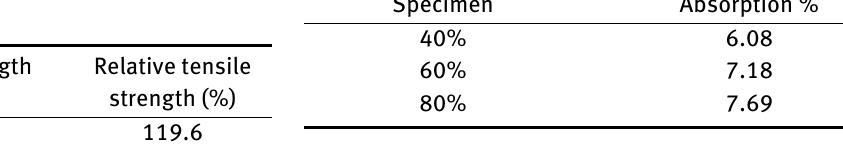
Table 21: Flexural strength of geopolymer mortar reinforced with 1% steel fibers